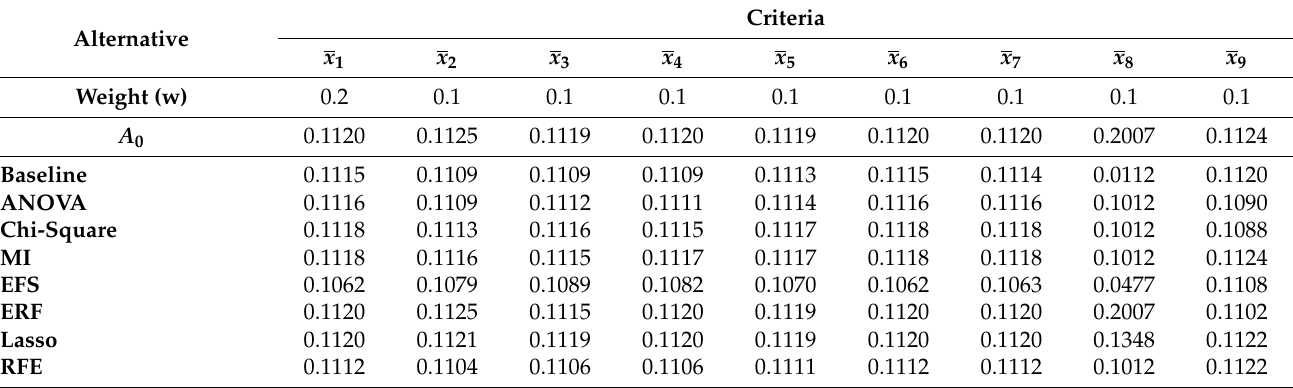
Table 5. Normalized decision-making matrix X on each criterion.